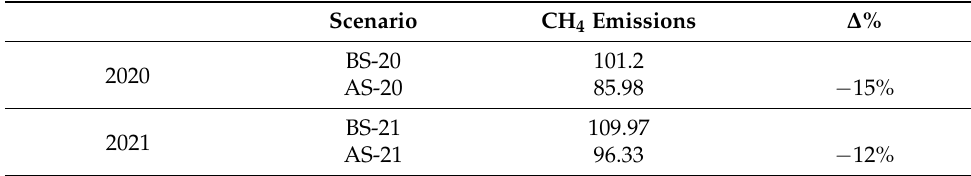
Table 2. Methane emissions during rice cultivation.